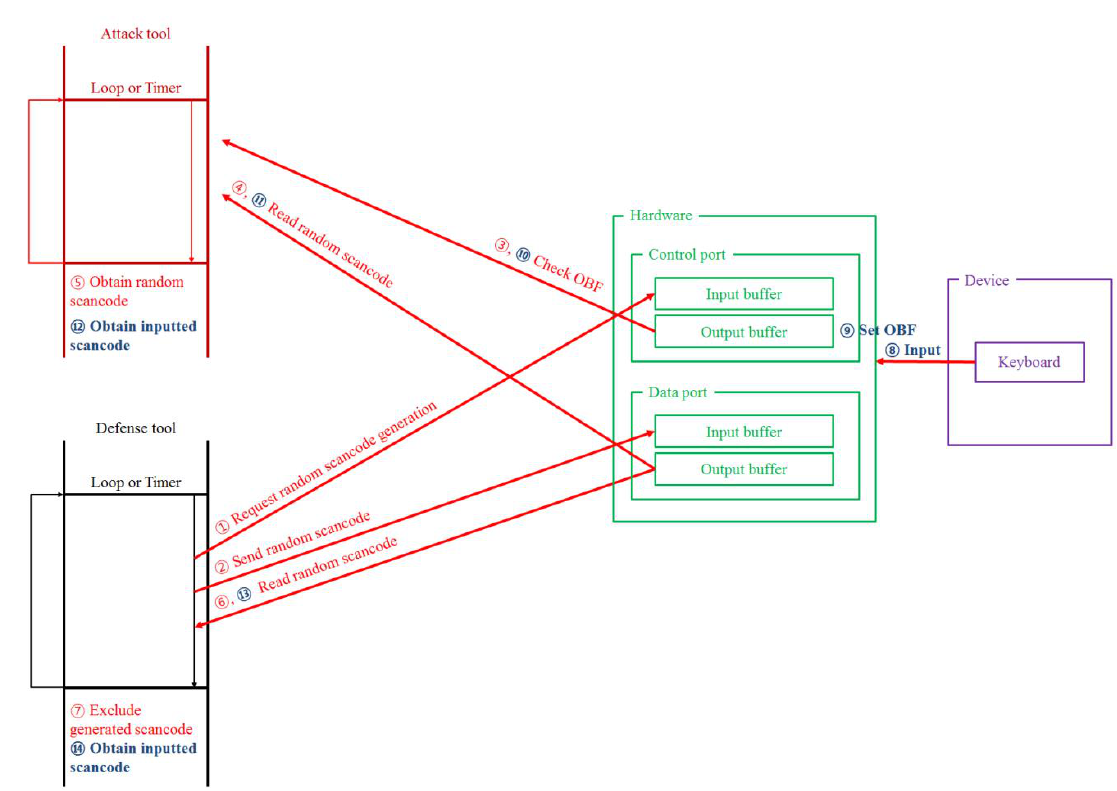
Figure 2. Operation process of the keyboard data protection technique using random scancode generation.